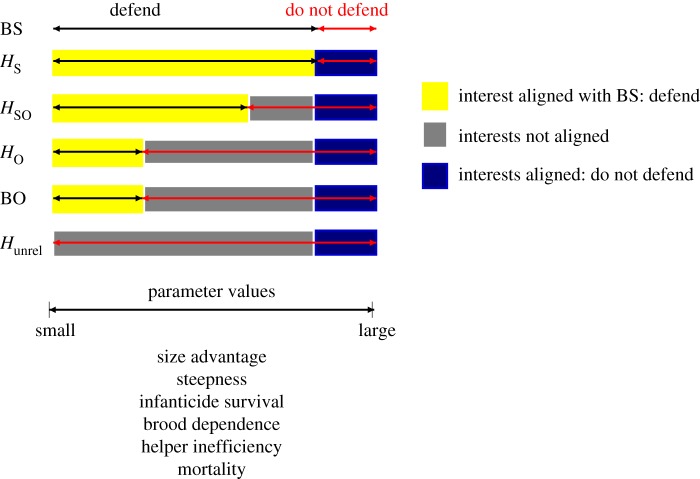
Schematic summary of positioning of switch points for each group member, depending on variation in the different parameter values.